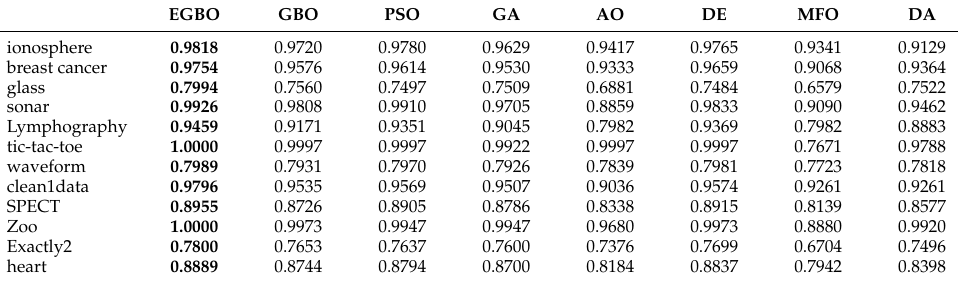
Boldface indicates the best result. Table 11. Results of the accuracy measure.